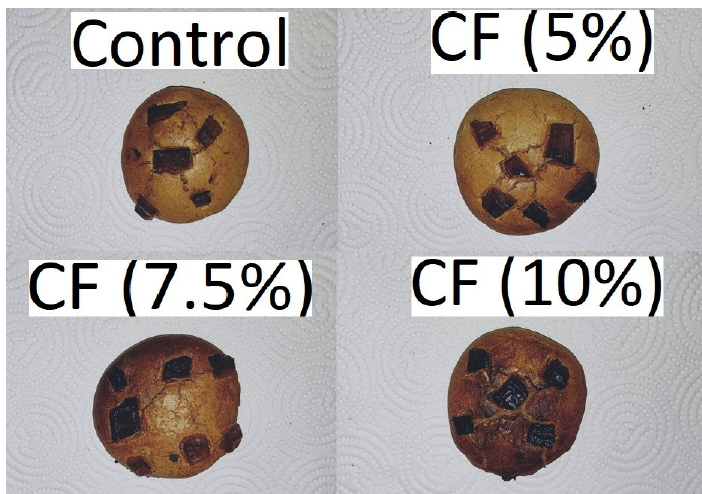
Figure 3. Appearance of the biscuits with cricket proteins.